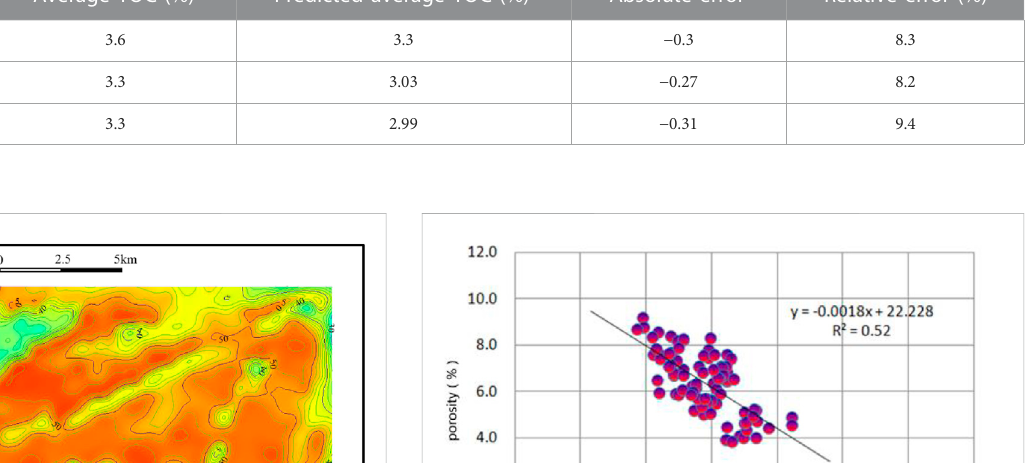
TABLE 3 Statistical table of average TOC seismic prediction errors of shale in the W204 well area. Well number